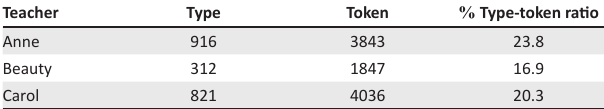
TABLE 2: The type-token ratio of classroom